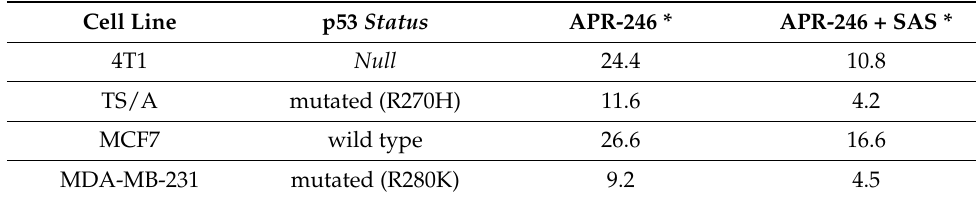
Table 1. APR-246 IC 50